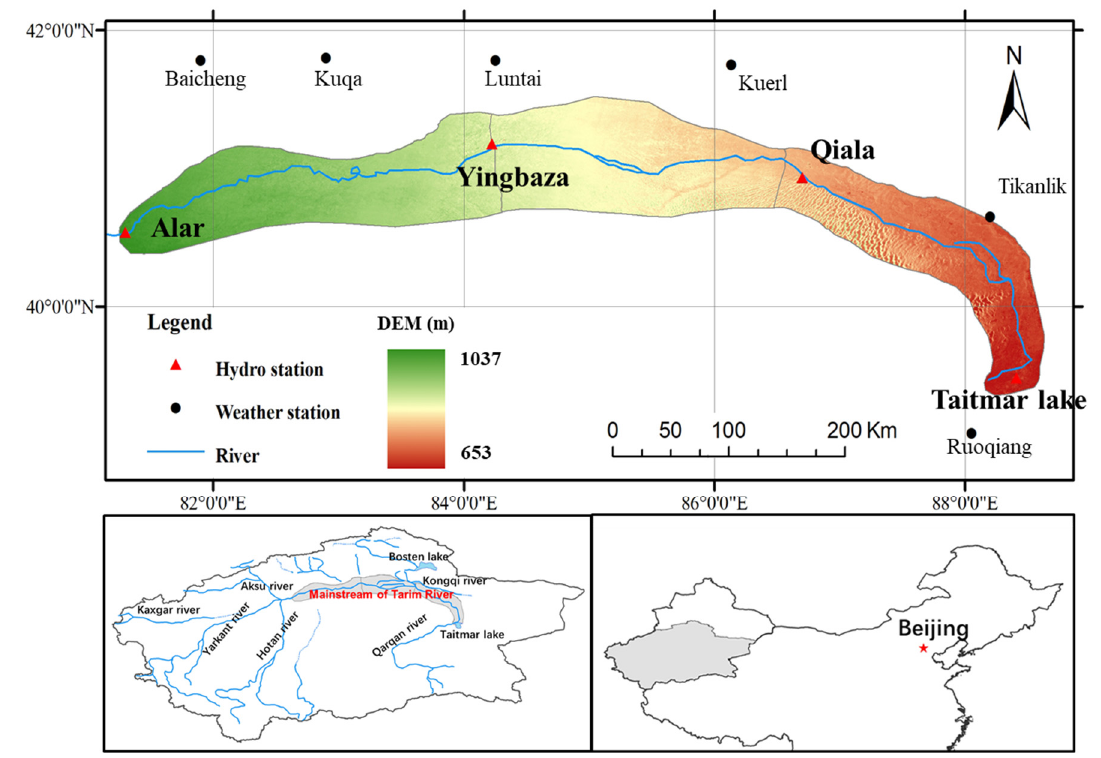
Figure 1. Schematic diagram of the mainstream Tarim River basin.